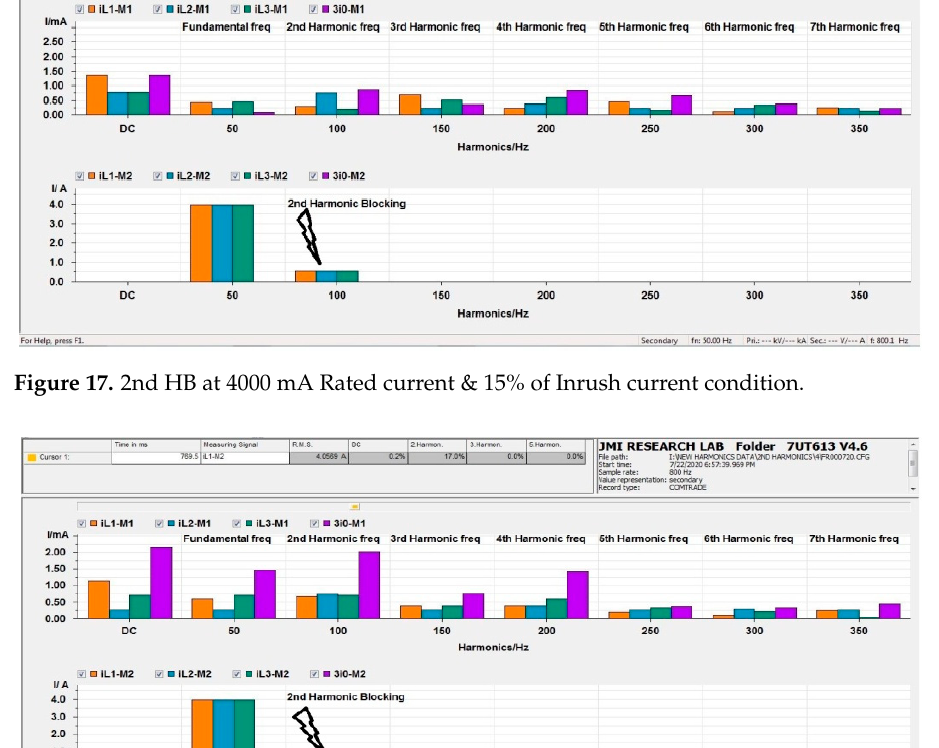
Figure 18. 2nd HB at 4000 mA Rated current & 18% of Inrush current condition.